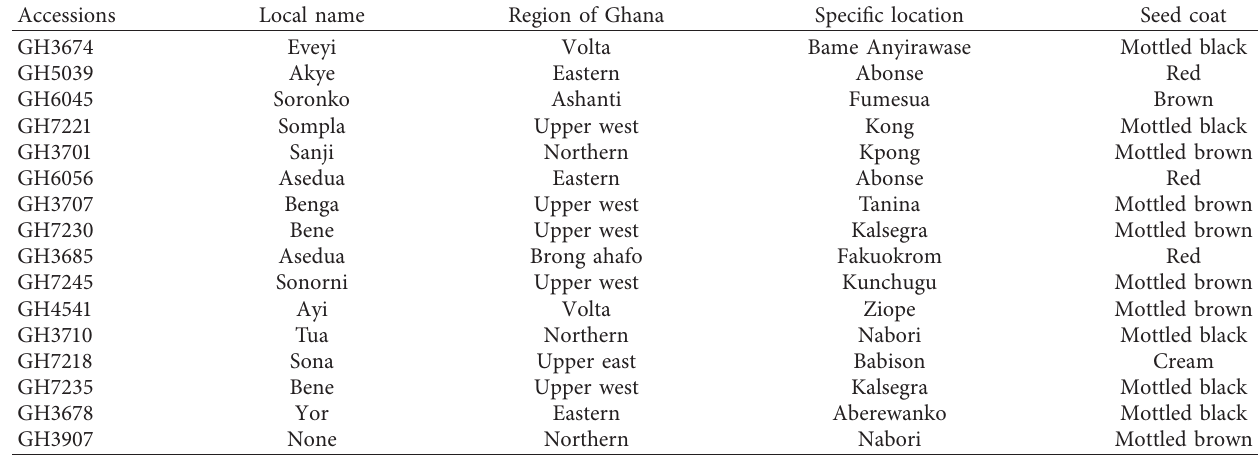
Table 1: Some passport data on cowpea accessions used for the study.